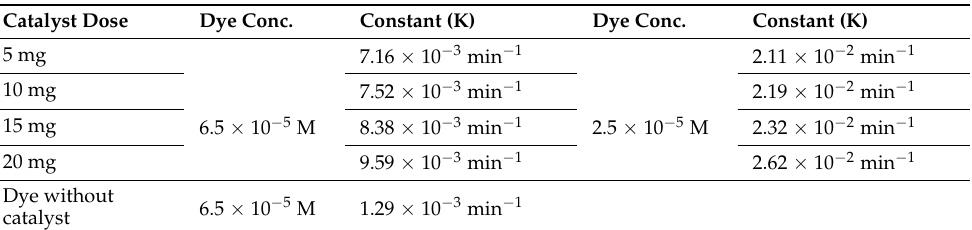
Figure 8. Graphs for various concentrations of 5, 10, 15, and 20 mg of ZnO that contains psyllium: ( a ) Ct/Co curve, ( b ) kinetics of degradation, and ( c ) efficiency of degradation at low concentration. Table 2. The calculated rate constants for the reaction kinetics of methylene blue degradation. Catalyst Dose Dye Conc. Constant (K) Dye Conc. Constant (K)